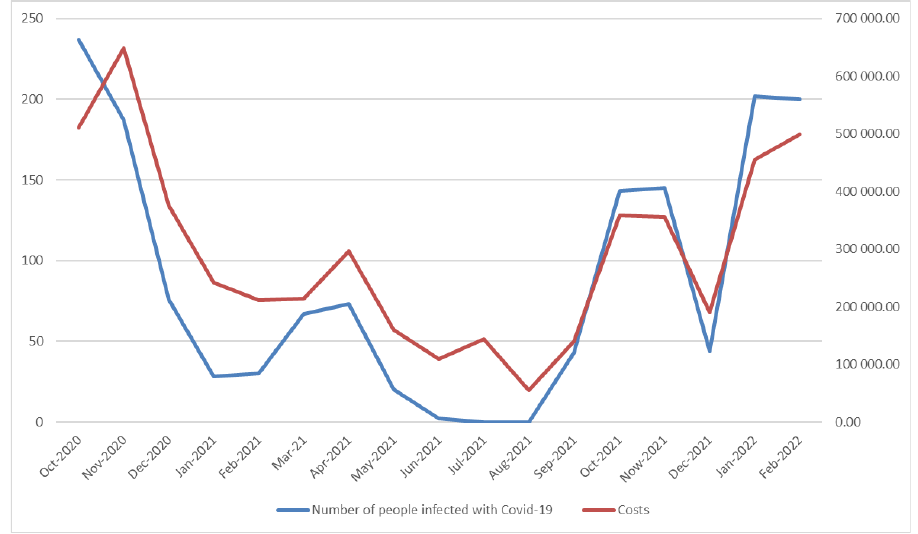
Figure 14. The number of people infected with COVID-19 and costs incurred for the same period,